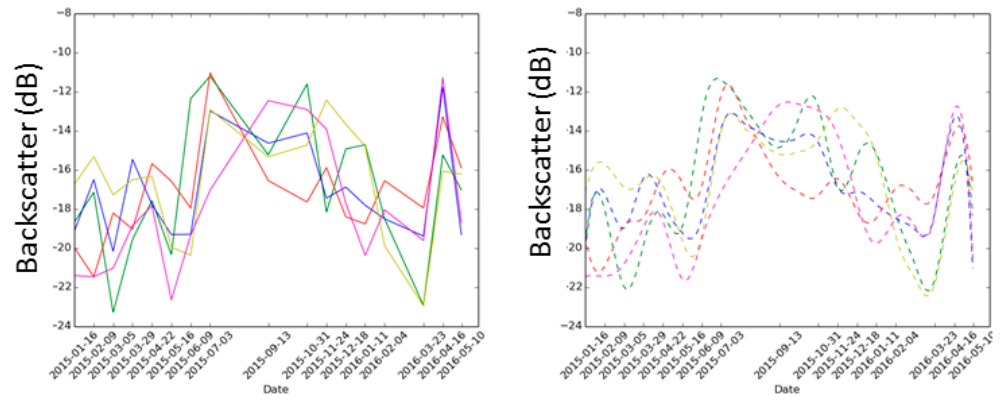
Figure 5. Example interpolated and smoothed time-series Sentinel-1 shown for rice pixels in northern Myanmar